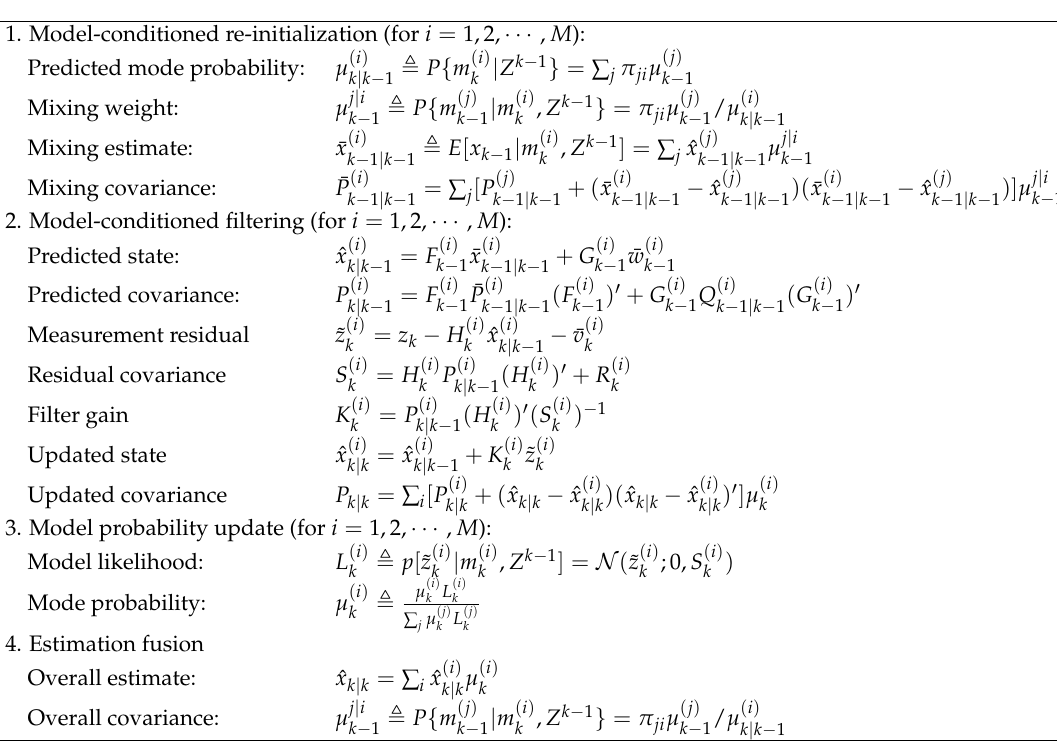
Table 1. One cycle of IMM